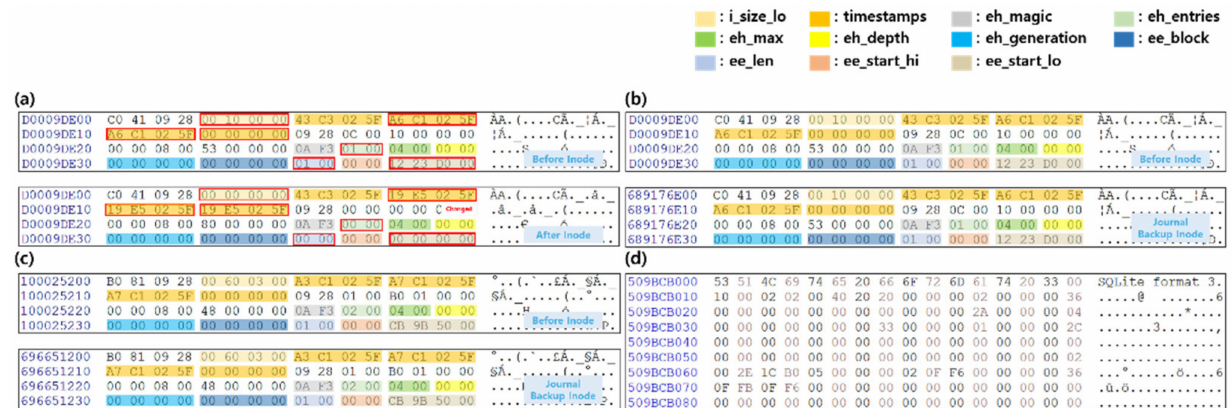
Figure 9. Metadata analysis of filesystem before and after data deletion using scenario III ( a ) Compar- ison of/data/data/com.kakao.talk’s directory entries before and after deleting app data ( b ) Compari- son of/data/data/com.kakao.talk’s inode before deletion and journal backup inode ( c ) Comparison of kakaotalk.db’s inode before deletion and journal backup inode ( d ) Comparison of kakaotalk.db’s data area found based on journal backup inode. The red box indicates changed fields before and after deletion.